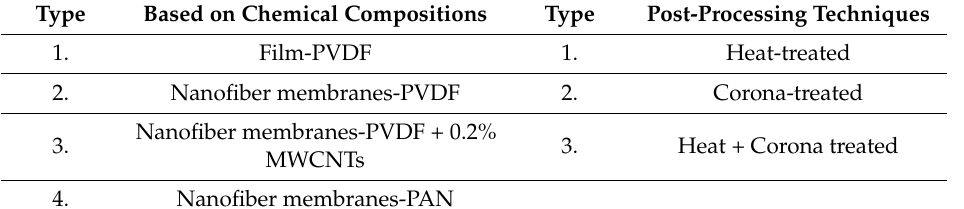
Table 1. Sample categories used in the experiments in this